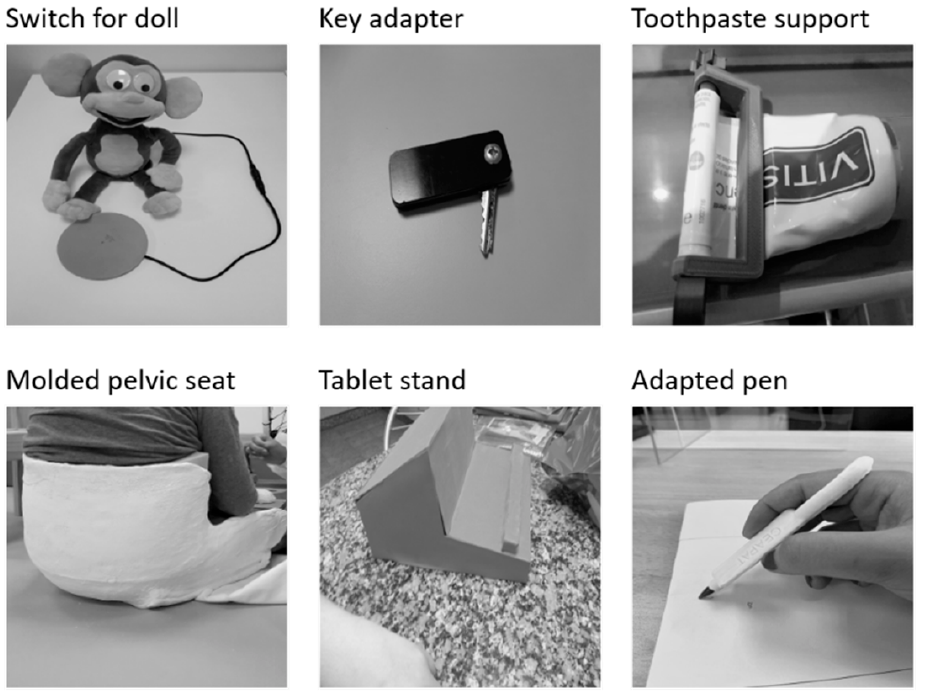
Figure 2. Low-Cost Assistive Technology created. Figure 2. Low ‐ Cost Assistive Technology created. Concerning the priorities and needs of the participants in vital areas, assessed with Work Initial Sheet of MPT, the main domains in which people had difficulties were mobility ( n = 7), self-care ( n = 7), and manual skills and use of hands ( n = 6). In this sense, the